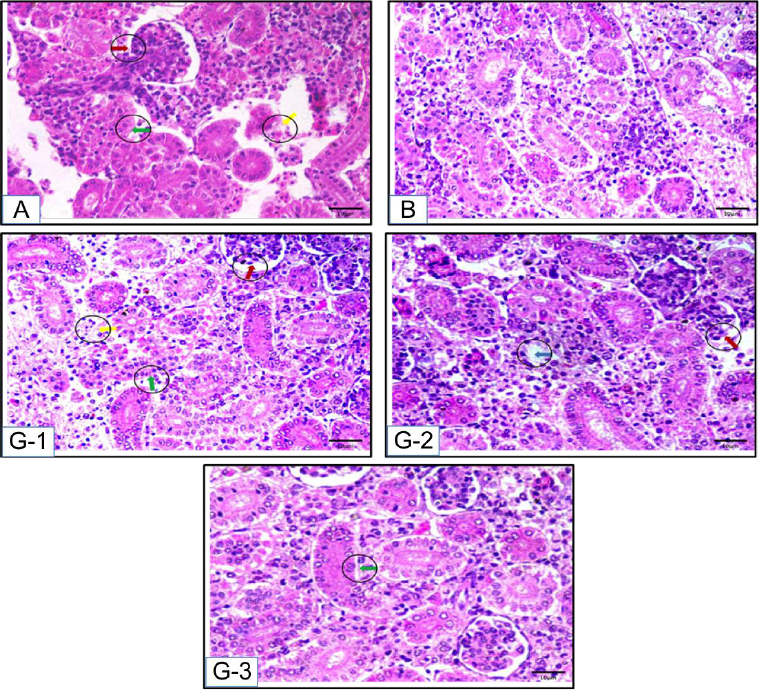
Figure 4. Photomicrographs (400×) of kidneys of the common carp ( C. carpio ) experimentally exposed for 28 days to CuO NPs (1.50 mg/L) as positive control ( A ; C-positive group), to no treatments as negative control ( B ; C-negative group), and to different concentrations of the fenugreek ( T. foenum-graecum ) extract at 100 mg/L ( G-1 ), 125 mg/L ( G-2 ), and 150 mg/L ( G-3 ). Fish kidneys from the positive control showed various histological abnormalities including swollen tubules (green arrow), abnormal glomerulus (red arrow), and complete degeneration (yellow arrow). Fish from groups treated with the fenugreek showed dose-dependent curative effects in their kidneys even if some tissue damages were observed, such as necrosis and tubular degeneration (blue arrow). The scale bar represents 10 µm; five fields of one histological section per sample were analyzed.